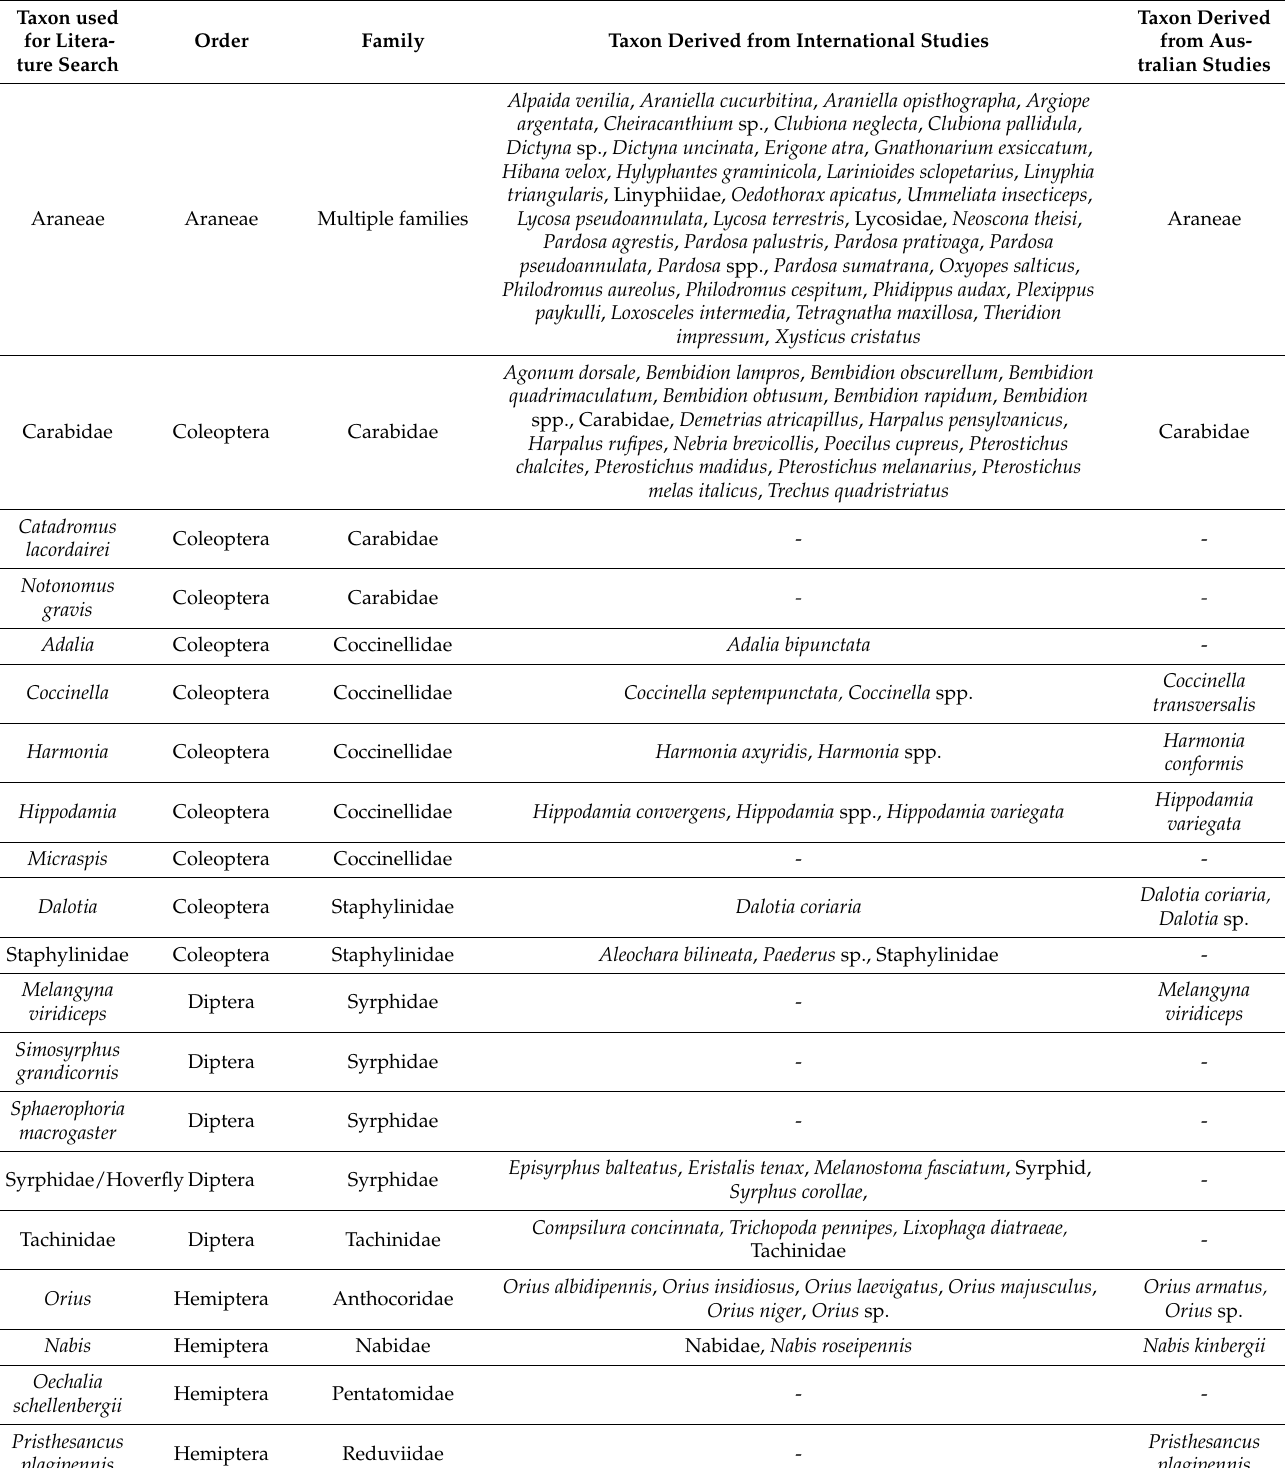
Table 2. Taxa included in our systematic review and their corresponding order and family. The findings for the taxon (species, genus, family, or order) used in the search term (i.e., in the first column) are presented in the last two columns, separating those where studies were conducted in Australia or internationally. A dash (i.e., -) in either of the last two columns indicates no relevant toxicity data were